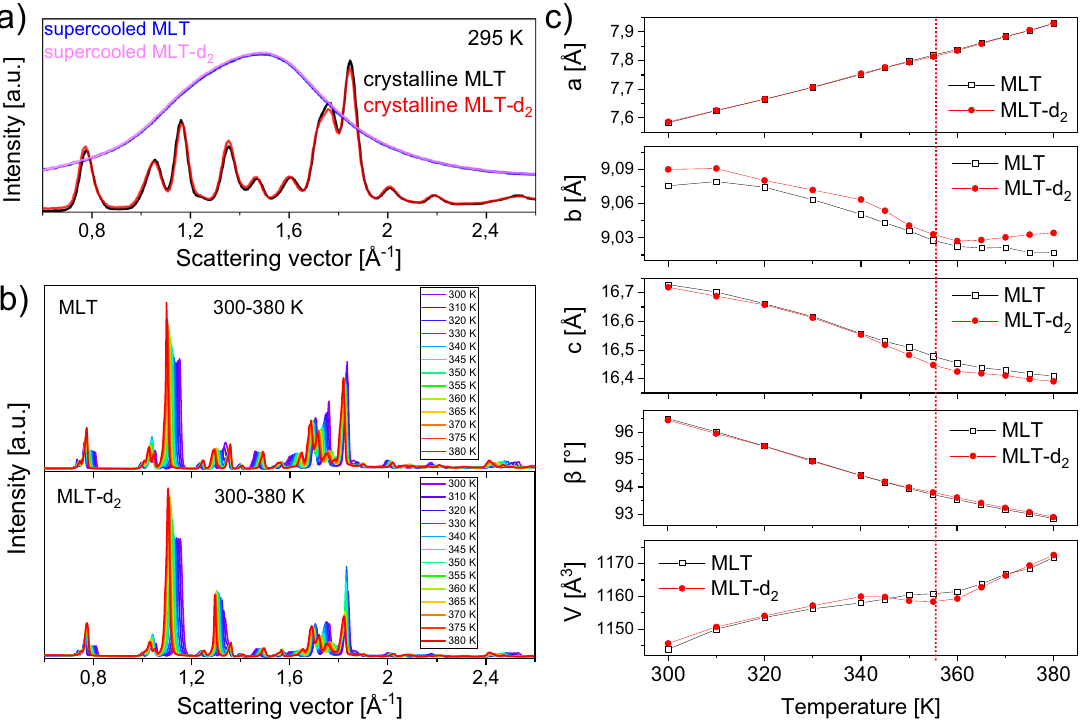
Figure 3. Comparison of XRD patterns, collected using Ag X-ray lamp, for MLT and MLT-d 2 in the crystalline and supercooled liquid states at 295 K ( a ). The evolution of the diffraction patterns, collected using Cu X-ray lamp, during heating the initial crystals from 300 to 380 K ( b ). Panel ( c ) presents the changes in the unit cell parameters a , b , c , angle β , and volume V as a function of temperature. The lines act as guides for the eye. The vertical dotted line highlights the point at T = 355 K for MLT-d 2, where the unit cell volume locally drops. Error bars are smaller than the plotted